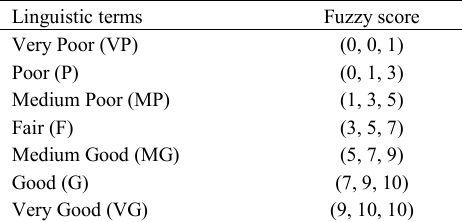
Table 2. Fuzzy evaluation scores for the